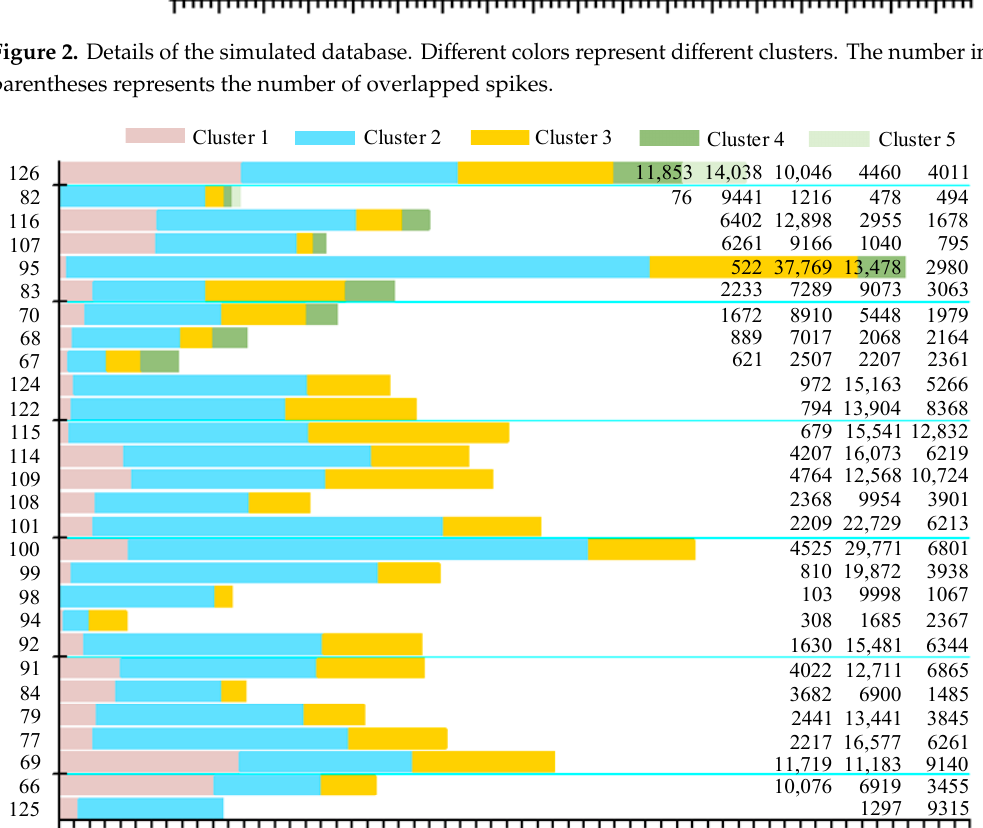
Figure 3. Details of the experimental datasets. Different colors represent different clusters. The number in parentheses represents the number of overlapped spikes.